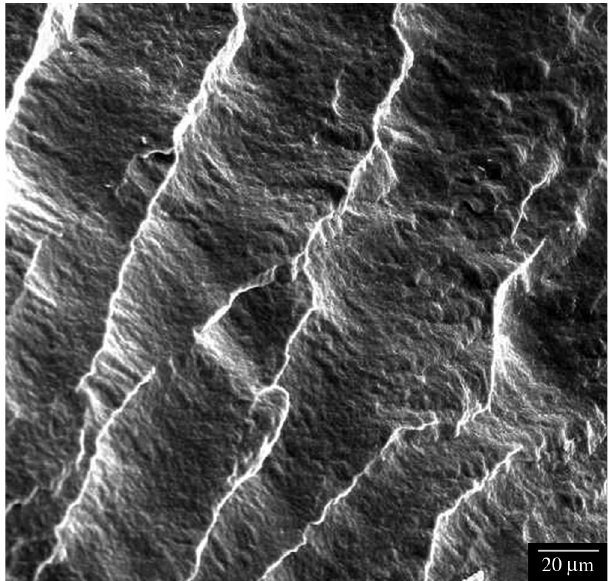
Figure 1. SEM micrograph of the fractured surface of a injection molded P(3HB) specimen. 500x.